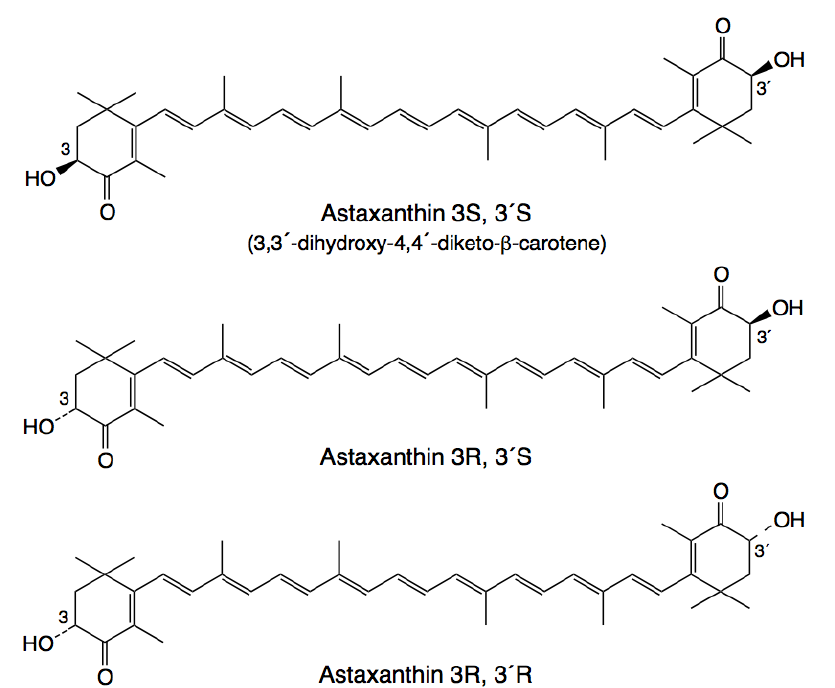
Figure 1. Stereoisomers of astaxanthin